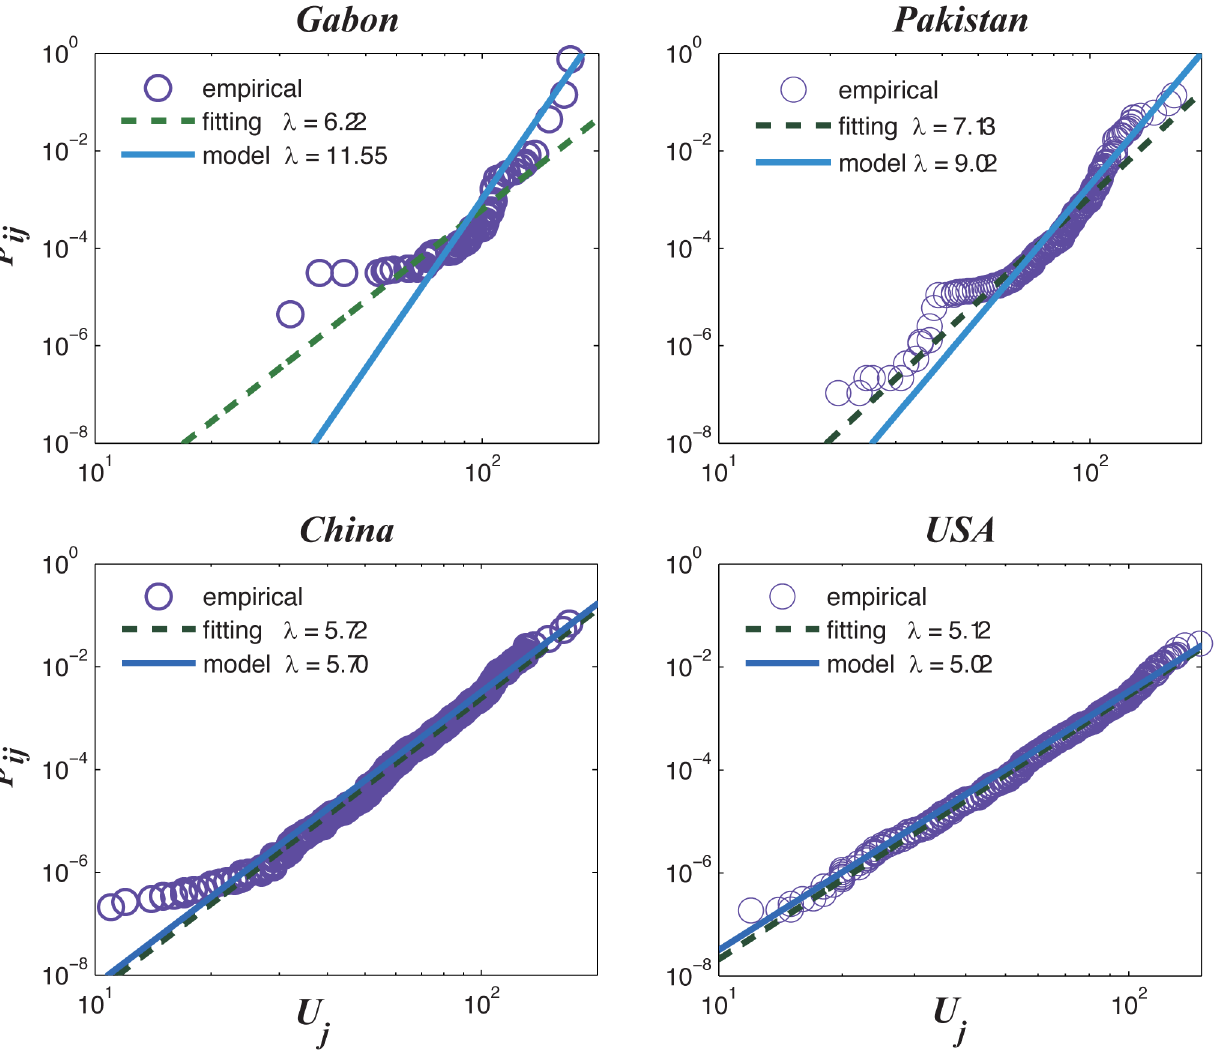
Fig 6. Empirical relationship between p ij and U j as well as the predicted exponents for four selected countries. The green dashed line represents the best fit to the empirical